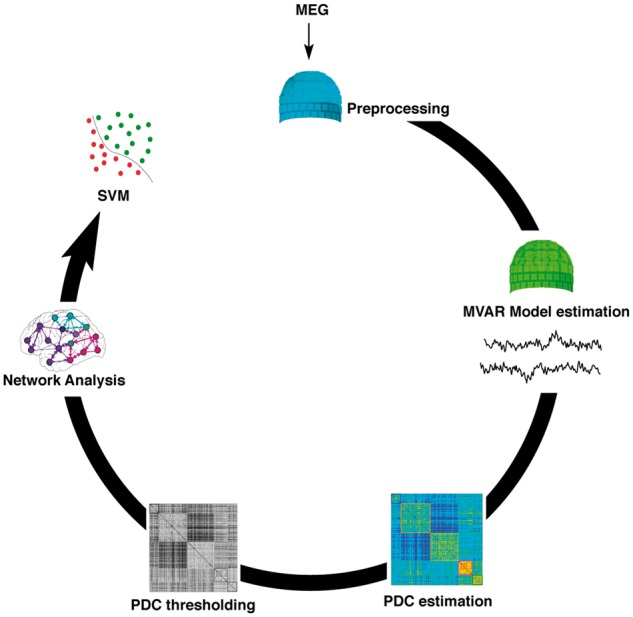

Data analysis pipeline.
Clockwise from top: Preprocessing, to remove biological artefacts using MaxFilter and independent component analysis denoising; estimation of effective connectivity using MVAR; compiling the association matrix between sensors by PDC; applying a statistical threshold to create a binarized graph, represented by the connectivity matrix; graph network analysis to estimate local efficiency; and group classification using a support vector machine (SVM).